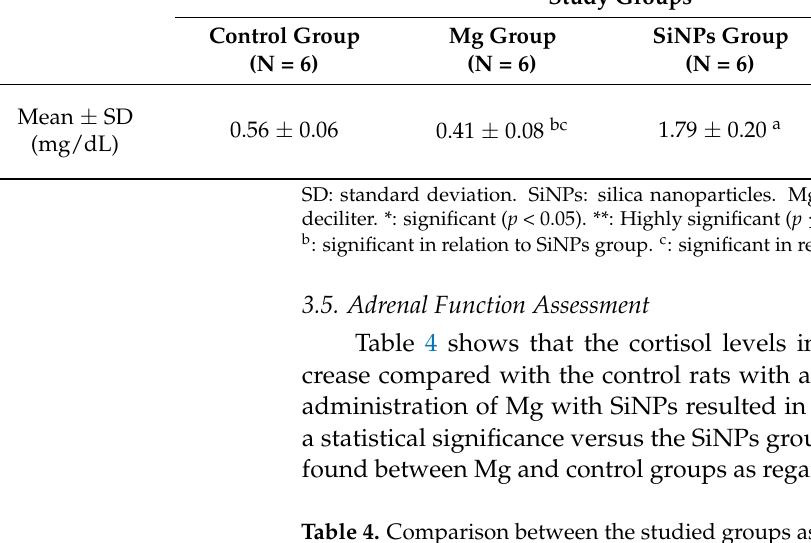
Table 4. Comparison between the studied groups as regards serum cortisol in the studied groups. Study Groups